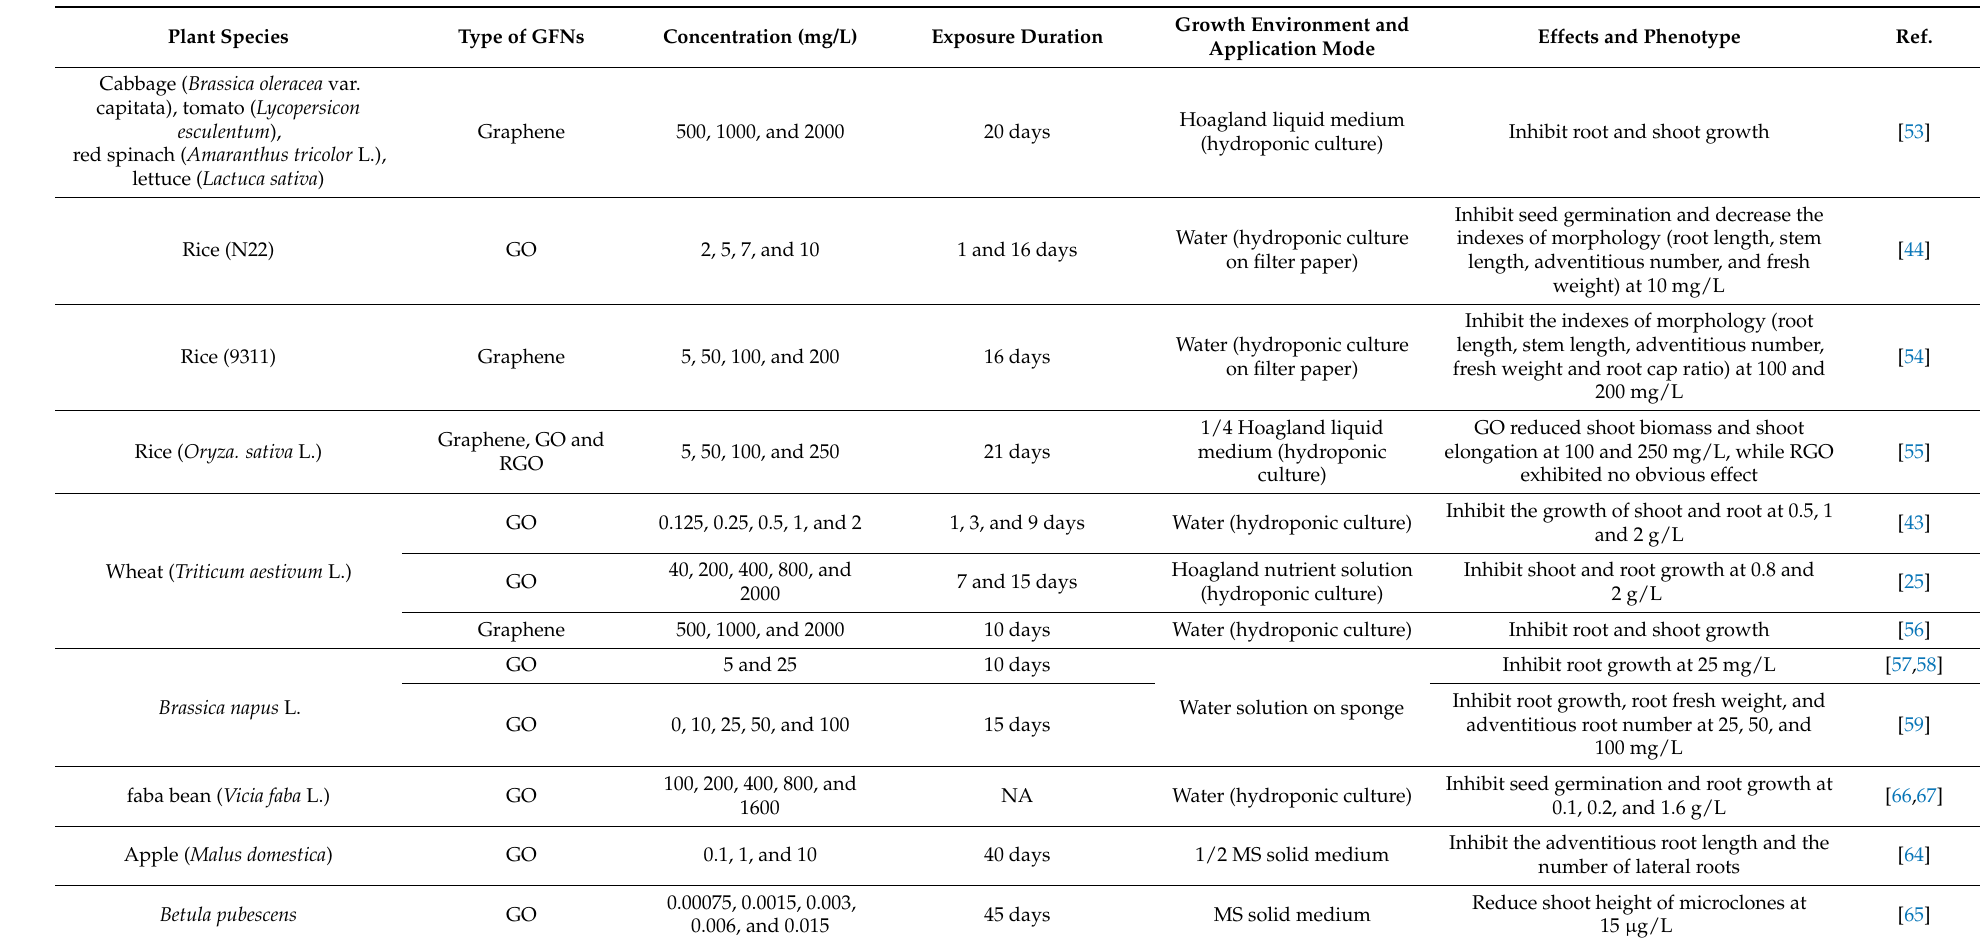
Table 2. Negative effects of GFNs in